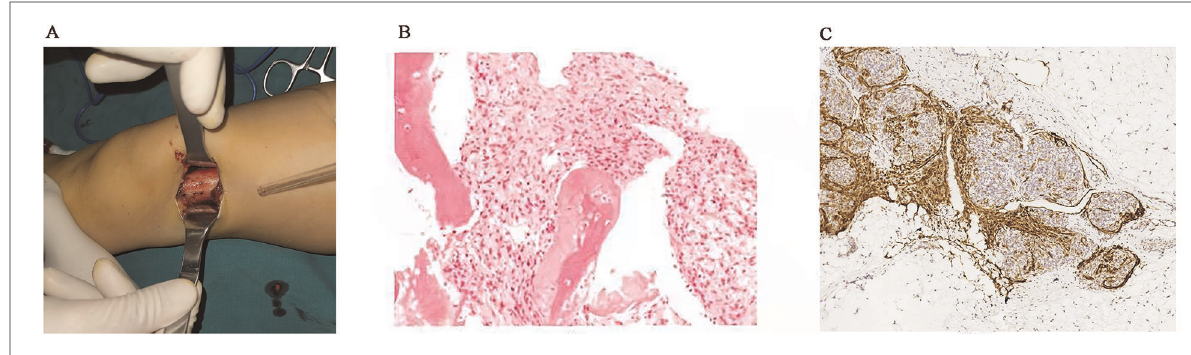
FIGURE 4 The left side of the distal femoral bone cortex was changing slightly rough in the operation ( A ), and the postoperative pathology results were showed ( B : HE, ×200; C : positive